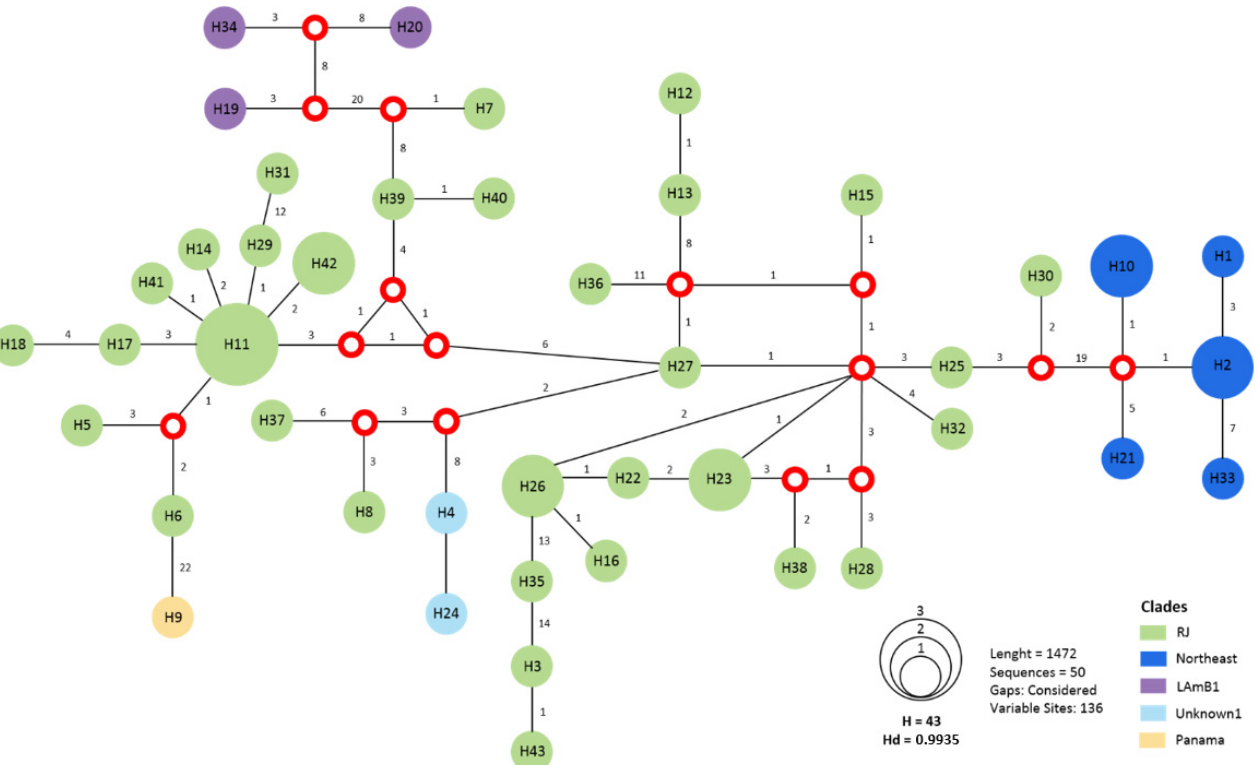
Figure 2. Median vector haplotype network demonstrating the phylogenetic relationships among the 50 isolates of the present study grouping both in RJ clade and others. Red dots represent median vectors. Circle size is proportional to the frequency of isolates (h). The numbers around each vertex represent the number of mutations separating each haplotype.